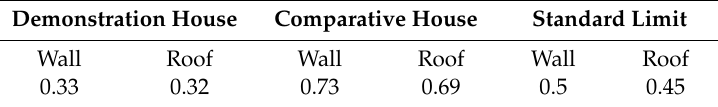
Table 5. Heat transfer coe ffi cient of the building